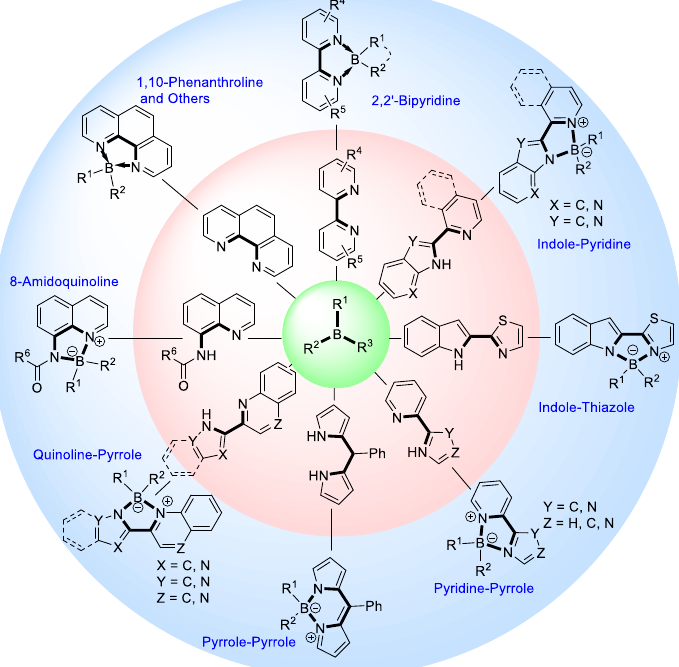
Figure 2. The methods for the formation of N , N ′-chelate organoboron derivatives [30–36].